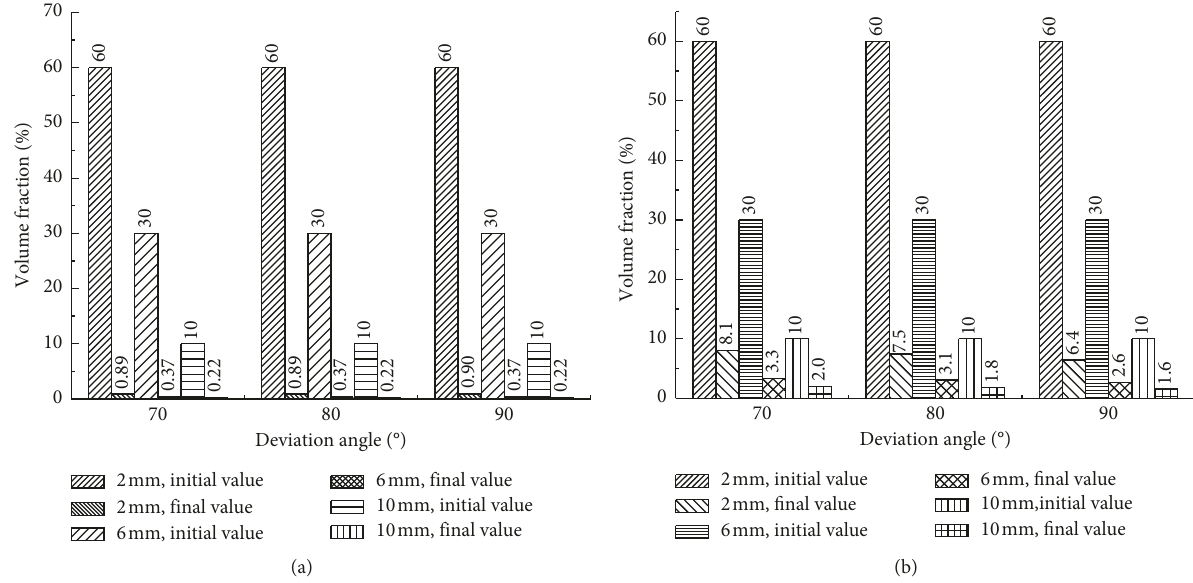
Figure 10: Influences of the well deviation angle and cuttings diameter on the volume fraction of cuttings: (a) under high rotational speed (40r/min) and high inlet flow rate (5L/s) conditions; (b) under low rotational speed (0r/min) and low inlet flow rate (1L/s)